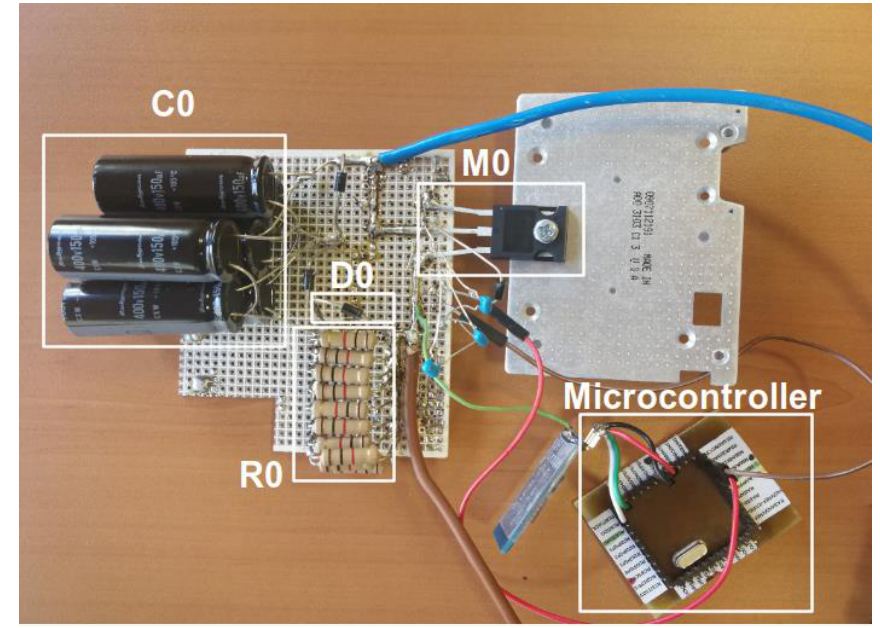
Figure 9. Picture of the common sweeping electronics.